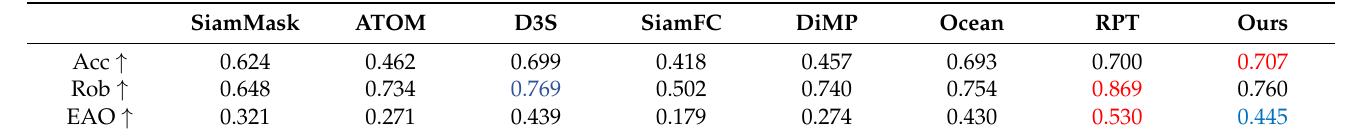
Table 3. Comparison of properties on the public VOT2020 dataset with regards to EAO, robustness, and accuracy. Red and blue represent 1st and 2nd,